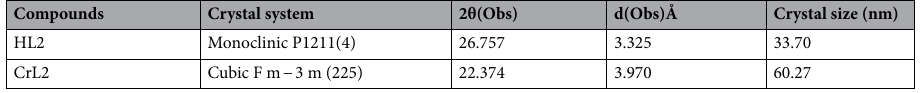
Table 5. Crystal system, d spacing values and crystal size of ligand HL2 and its CrL2 complex.